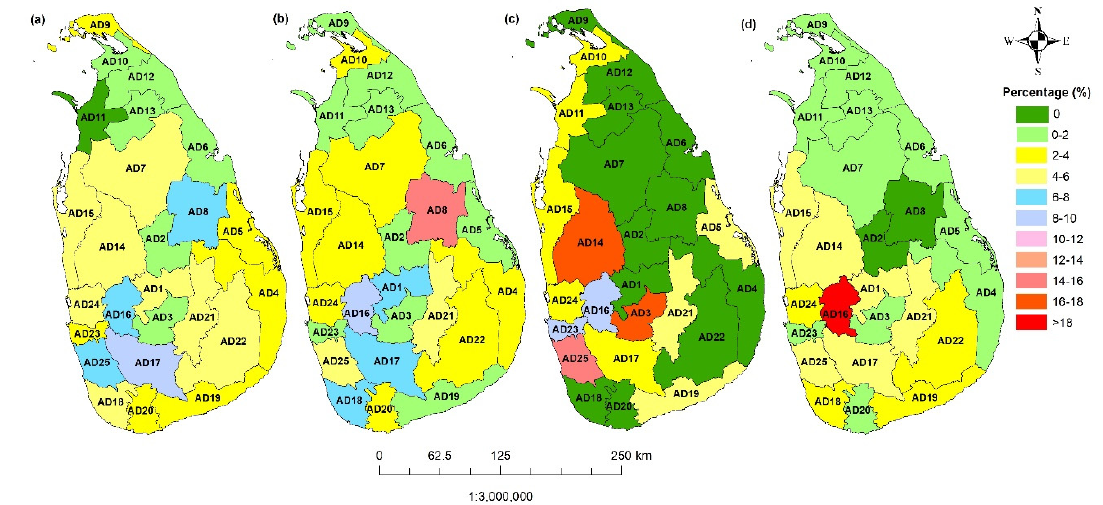
Figure 14. Distribution of the lightning accidents in the administrative districts of Sri Lanka, from 1974 to 2019: ( a ) deaths due to lightning strikes, ( b ) injuries due to lightning strikes, ( c ) destroyed houses due to lightning strikes, and ( d ) damaged houses due to lightning strikes.